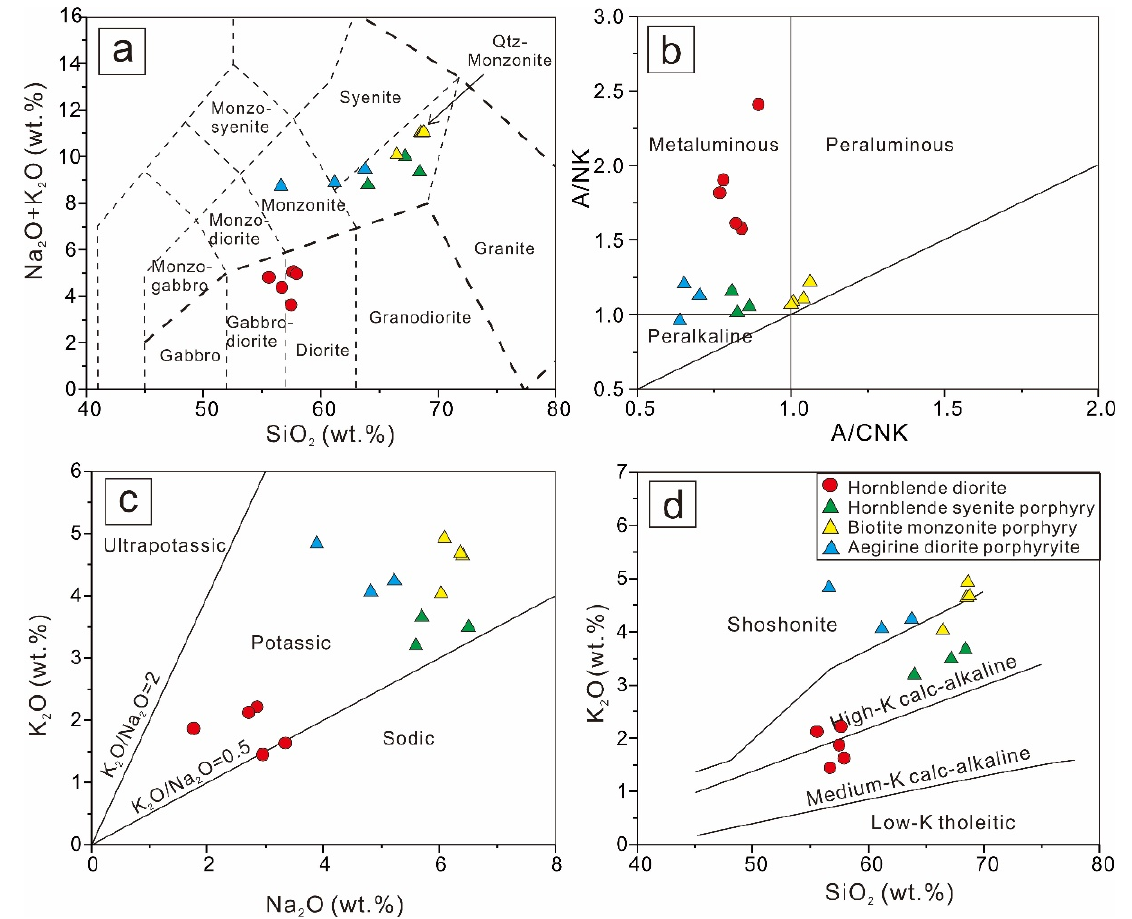
Figure 6. Geochemical diagrams of the alkaline complex in the Longbaoshan area. ( a ) TAS diagram, modified after [60]. ( b ) A/CNK versus A/NK. ( c ) Na 2 O versus K 2 O, modified after [61]. ( d ) SiO 2 versus K 2 O, modified after [62].